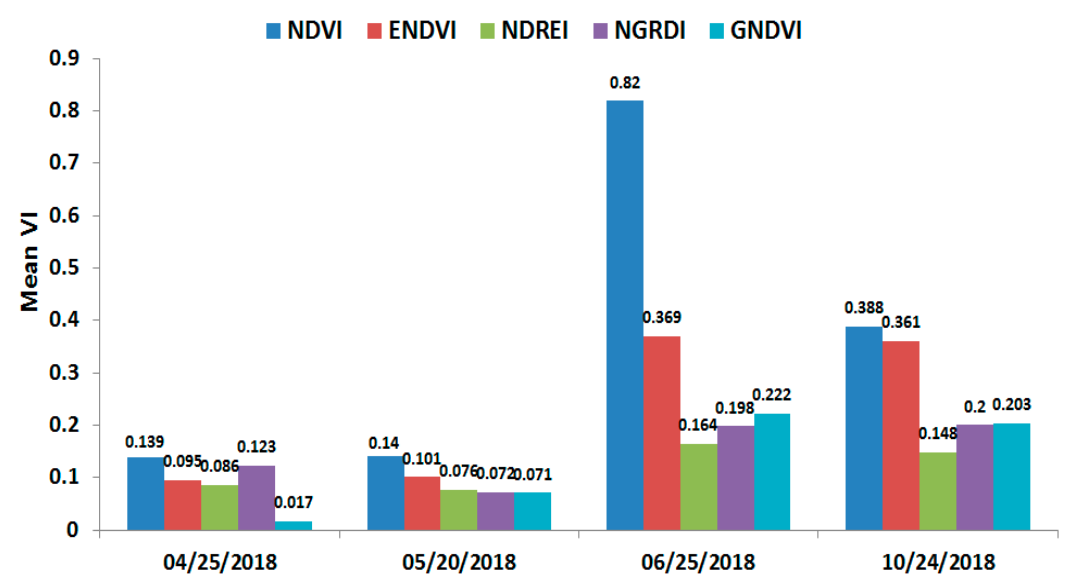
Figure 7. Mean values of the vegetation indices on each day.